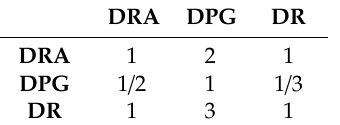
Table 9. Comparison matrix of the criteria location factors.